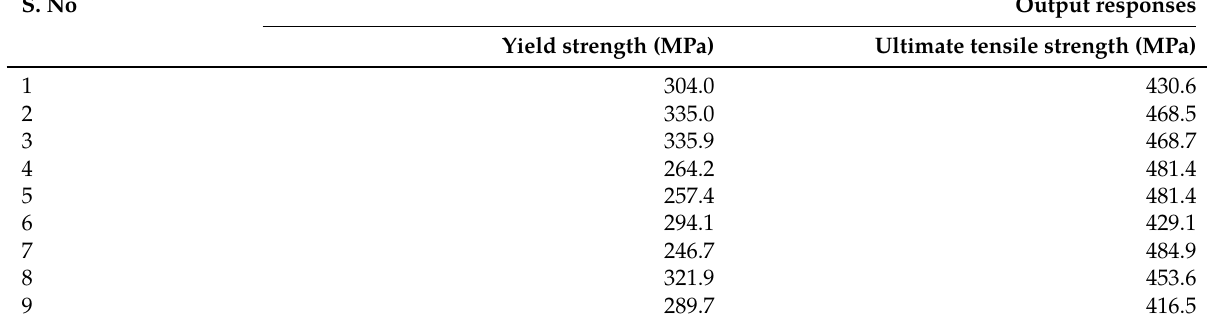
Table 3: Tensile tests